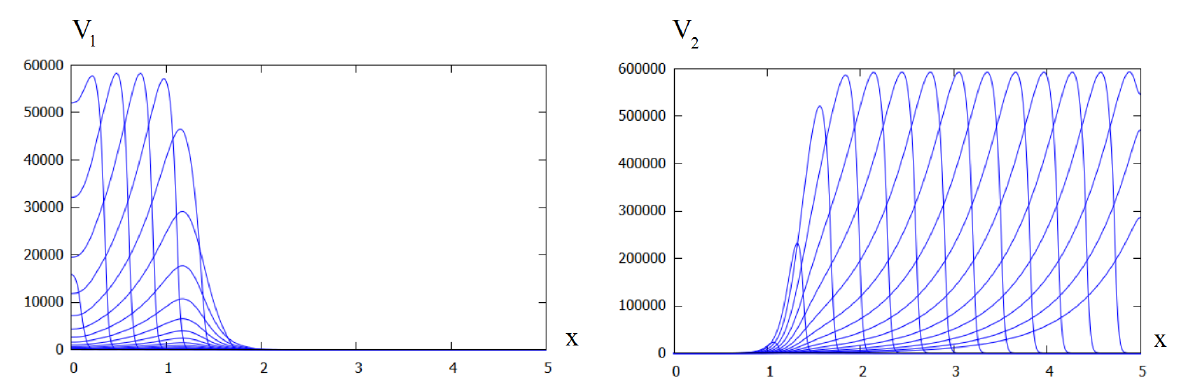
Figure 4. Distributions of V 1 ( x , t ) ( left ) and V 2 ( x , t ) ( right ) in numerical simulations of system (29)– (33). In the beginning of simulations, there is only the first virus variant. After some time, the second variant completely eliminate the first one. The values of parameters: a 1 = 0.01, a 2 = 0.1, b 1 = b 2 = 8 × 10 4 , D 1 = D 2 = 10 − 3 , β 1 = β 2 = 0.1, σ 1 = σ 2 = 1, τ = 2, u 0 = 1, i 10 = i 20 = 0, v 1,0 = 4.5, v 2,0 = 0, x 0 =